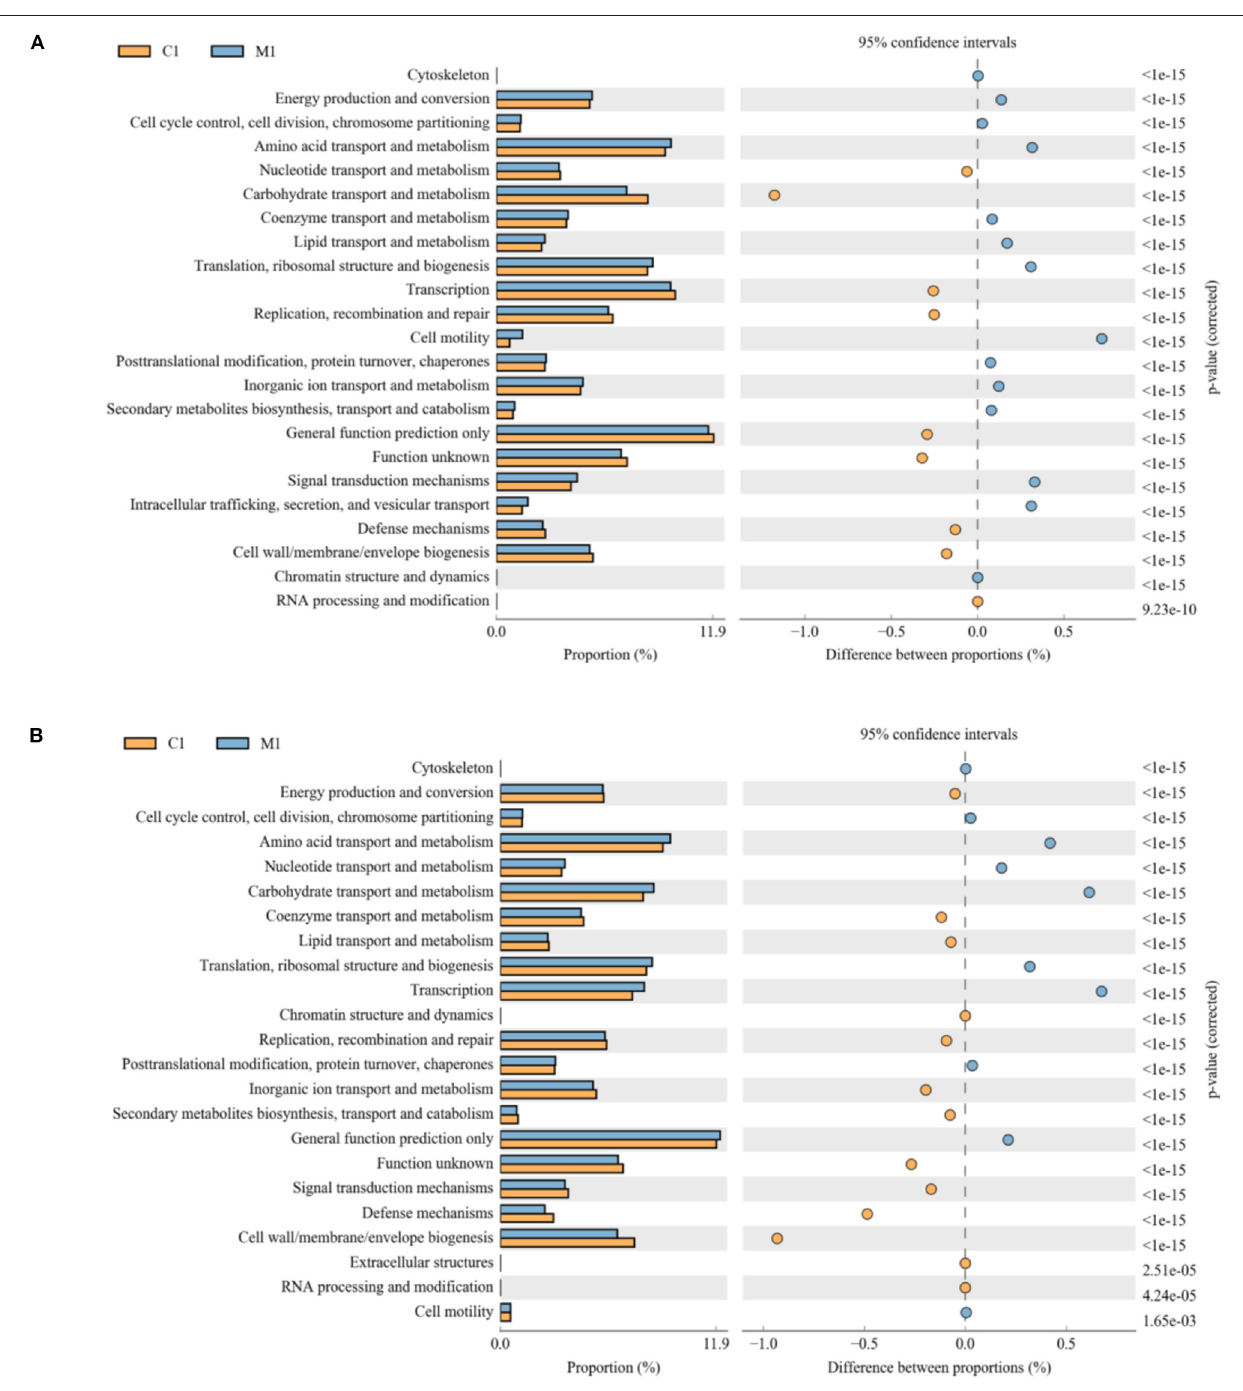
FIGURE 6 | Comparison of predicted pathway abundances between the groups by statistical analysis of taxonomic and functional profiles (STAMP). (A) CON vs. MLB at 21 d; (B) CON vs. MLB at 42 d. CON, control group, basal diet; MLB, basal diet + 400 mg/kg B. licheniformis